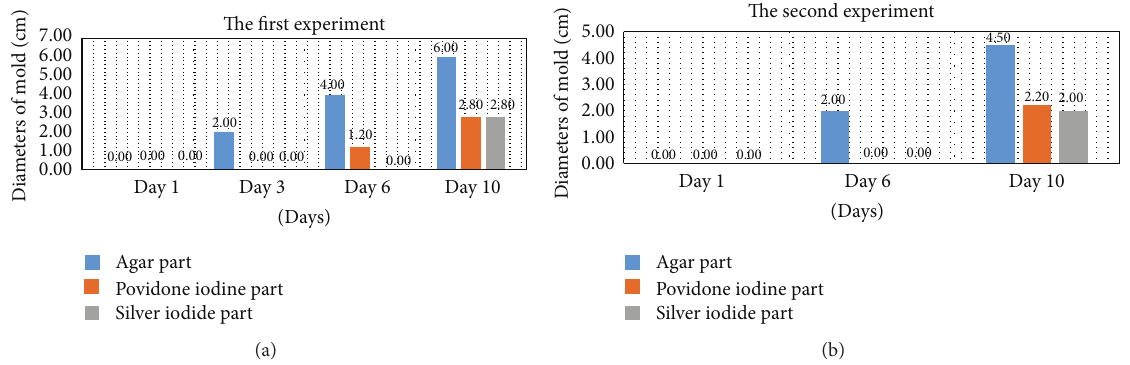
Figure 8: Bar graphs of conductance silver iodide bacteriostasis experiment for (a) result of the first experiment and (b) result of the second